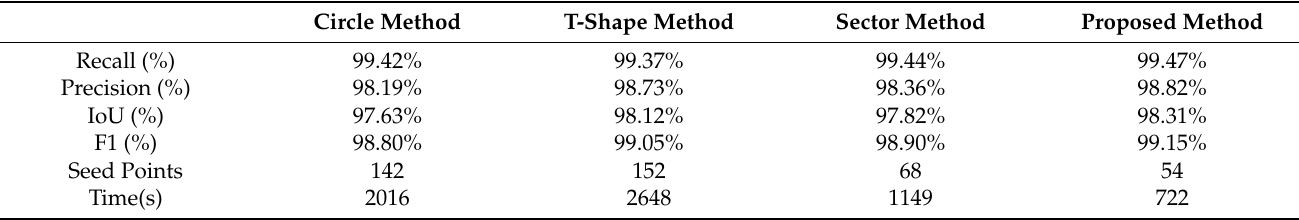
Table 4. Comparison information of different